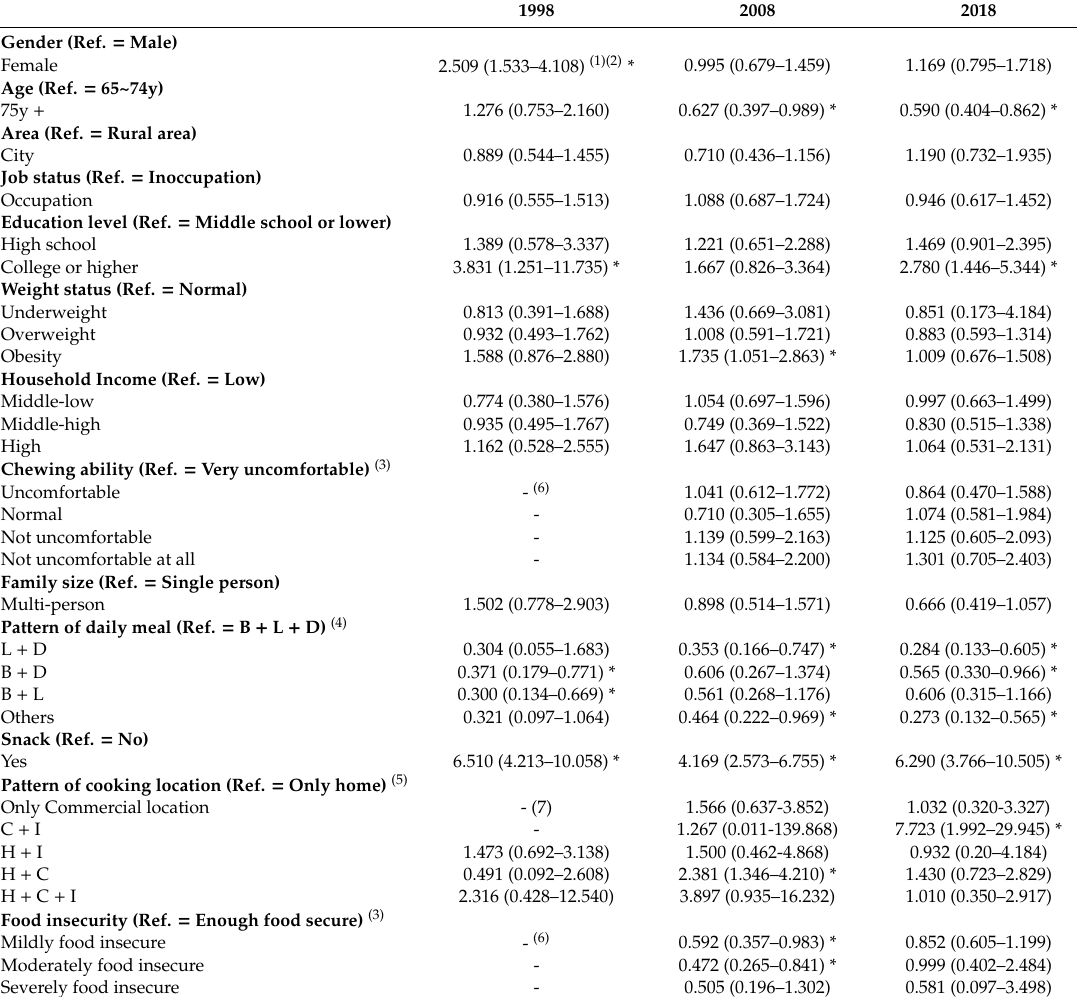
Table 7. Factors related to fruit and vegetable intake ( ≥ 400 g / day) in Korean elderly by each